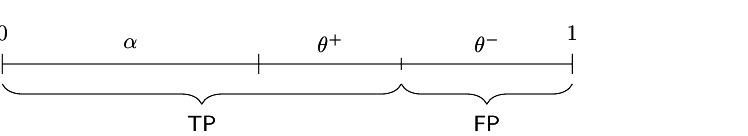
Figure 6. Estimating an upper bound for belief in receptor positivity. True positives (TP) and false positives (FP) can be used to derive a first equation in α Expr and θ Expr (Eq. 3). A second equation may be deduced by including TN and FN, Eq. (2). Both can be solved to estimate α Expr and θ Expr . From these follow upper bounds for the belief in positivity ( ˆ α Expr ) and negativity ( ˆ β Expr ), Eqs. (4 and 5),